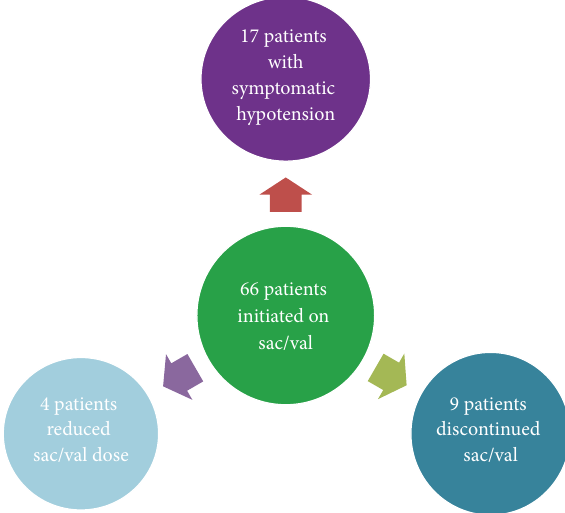
Figure 1: Overview of patients initiated on sacubitril-valsartan